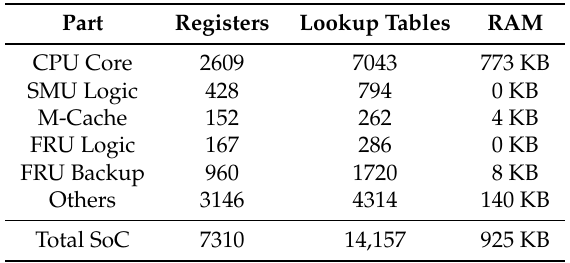
Table 9. The resources utilized by each part in